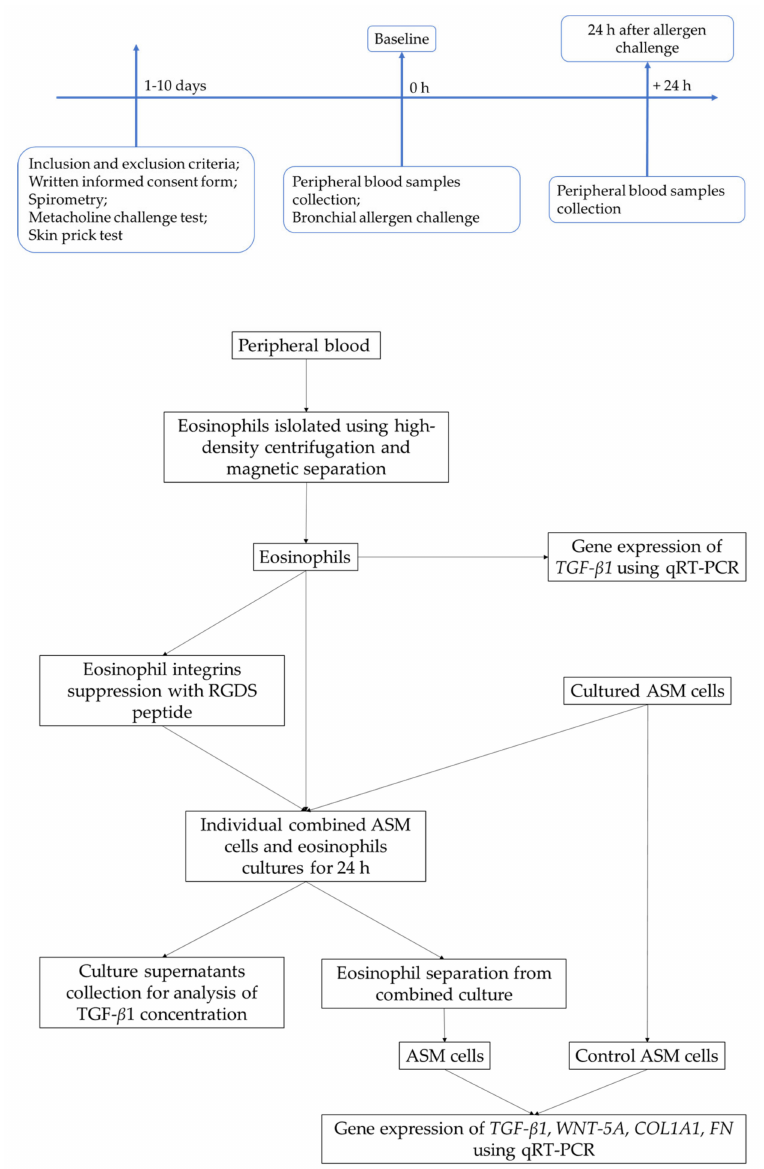
Figure 4. The flowchart of the study design: recruitment of study subjects, clinical examination, and experimental